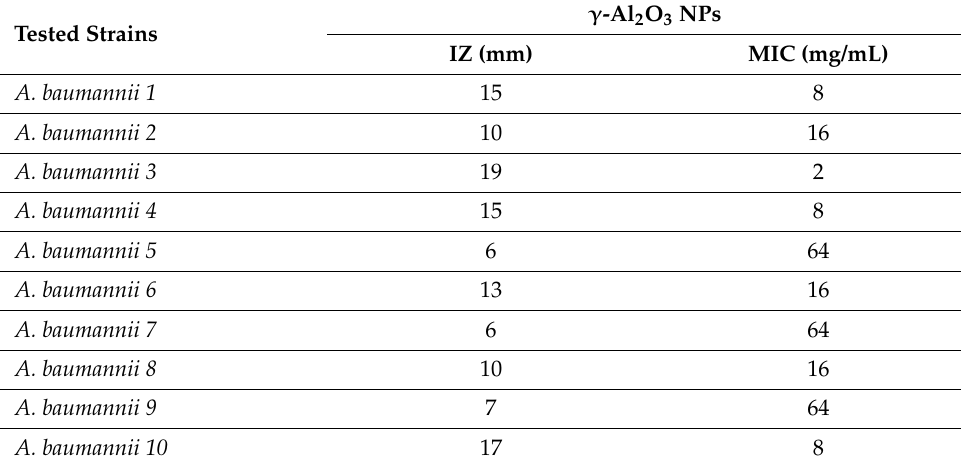
Table 2. Antibacterial activity of aluminum oxide nanoparticles. Tested